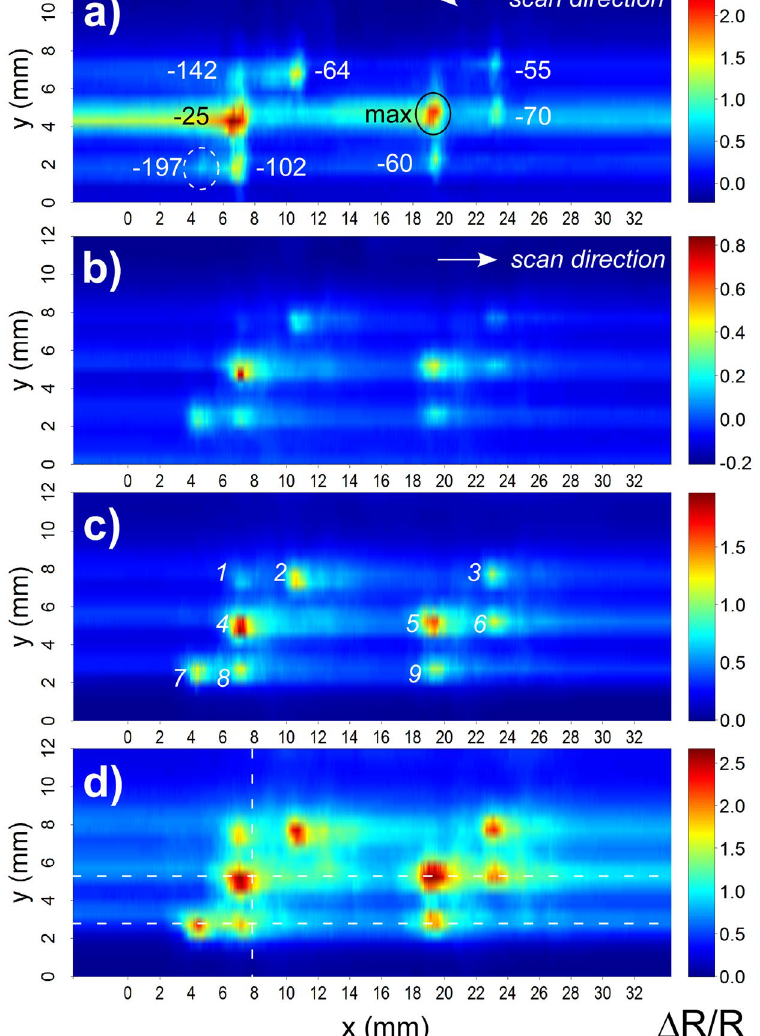
Figure 6. Images obtained from continuous scanning, using the finger illustrated in Fig. 4c. ( a ) The peak heights ( μ m) of the braille dots on this plate relative to the dot with the largest height are indicated. Scanning was conducted with a shallow contact. The image revealed height differences among the braille dots. ( b ) A scan performed with another sensor. ( c ) Increasing the contact depth used in ( b ) by 100 μ m, and ( d ) increasing the depth by another 100 μ m. Dot numbers and line scan positions used in Fig. 7 are indicated. Different color scales were used to permit